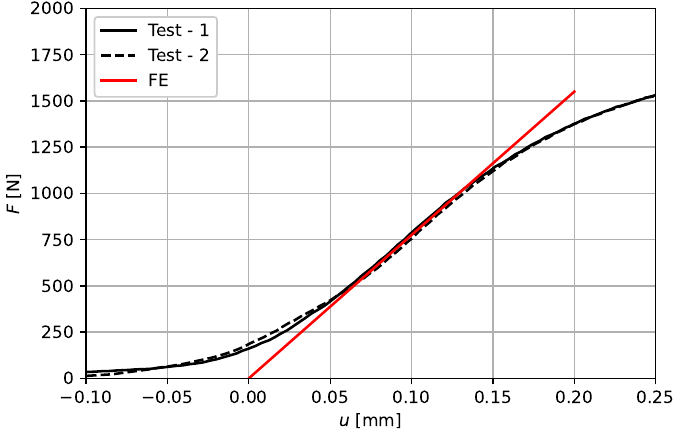
Figure 12. Validation of FE model: Resulting load-displacement curve of two tested LPBF produced scaffolds and equivalent FE